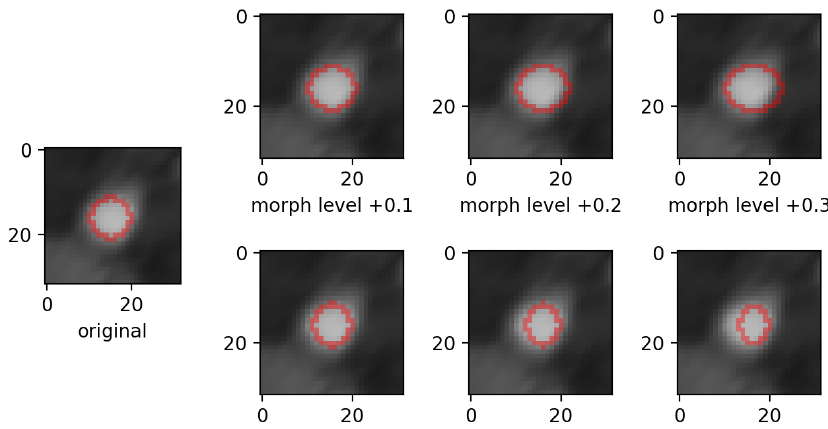
Figure 4. Example of mask morphing perturbation in the left-to-right direction. Top row shows dilations (the mask is prolonged), bottom row shows erosions (the mask is shortened). Only the mask contour is shown.